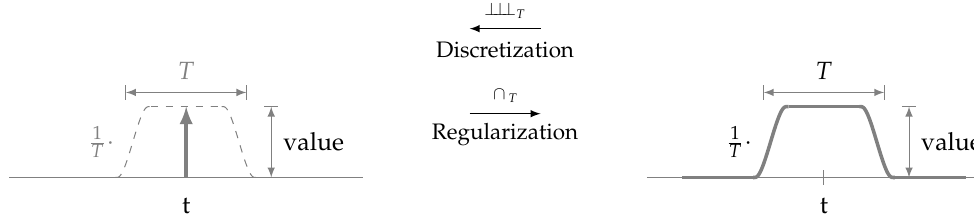
Figure 2. Equivalent pixel representations, Dirac’s delta ( left ) and Lighthill’s unitary function ( right